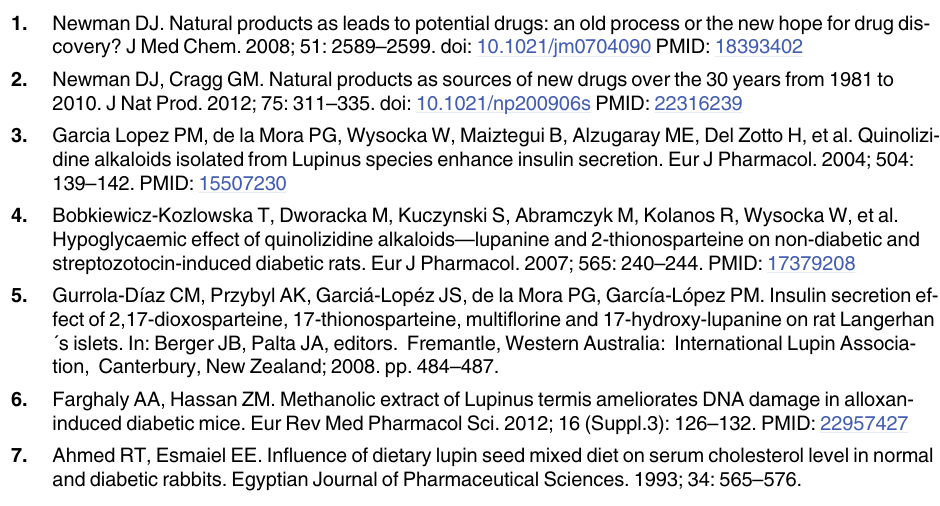
S1 Fig. Comparison of effects of oral antidiabetic drugs on glucose tolerance in mice. 55P0110 (90 mg/kg; A), sitagliptin (10 mg/kg; B), gliclazide (8 mg/kg; C), pioglitazone or met- formin (30 and 200 mg/kg; D) were orally administered to male C57BL/6J mice 45 min before a standard oral glucose tolerance test was started (3 g/kg). Means±SEM; 8 – 16 each; (cid:1) p < 0.05; † p < 0.01; ‡ p < 0.001 vs. vehicle. S2 Fig. Dose-dependent effects of 55P0110 and sitagliptin on glucose tolerance in mice. 55P0110 (45, 90, 180 mg/kg; A) or sitagliptin (1, 3, 30 mg/kg; B) were orally administered to male C57BL/6J mice 45 min before a standard oral glucose tolerance test was started (3 g/kg). Means±SEM; n = 7 – 9 each. S1 Table. Pharmacokinetic pilot data from mice treated with 100 mg/kg 55P0110. At 0 min, male C57BL/6J mice received by gavage an oral dose of 100 mg/kg 55P0110. One mouse was killed for blood sampling at each indicated time interval after drug administration. S2 Table. Compilation of original data. This file provides an Excel compilation of all original raw data that have been used in the